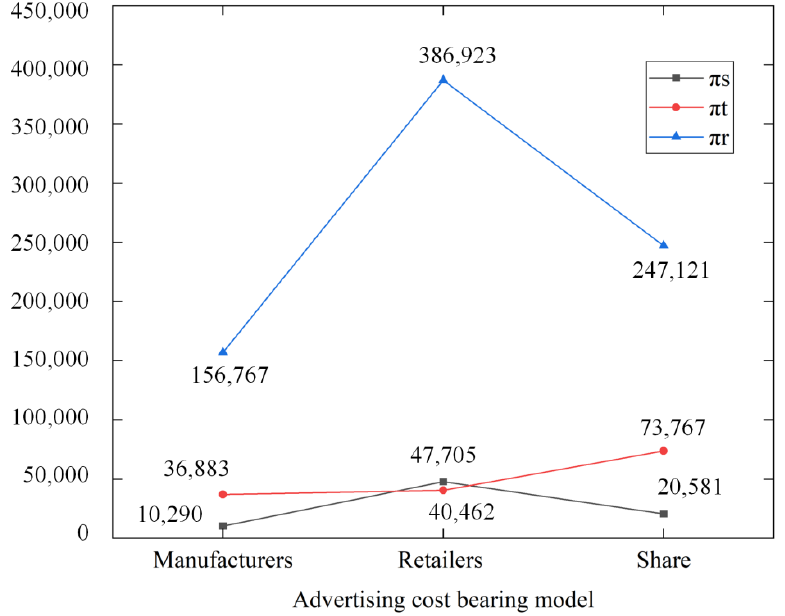
Figure 5. The changes in the profits of all parties in the supply chain under different advertising cost-sharing models.